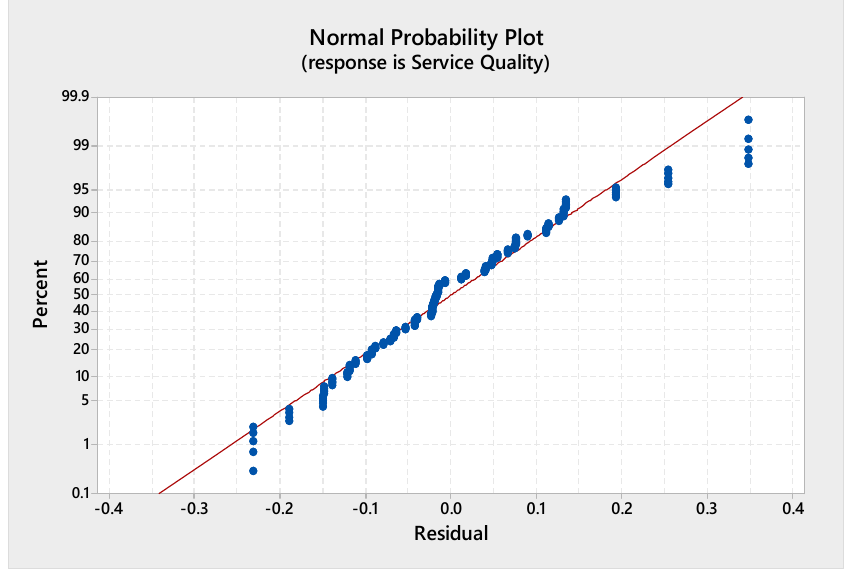
Figure 2. Normal probability plot for service quality scores.